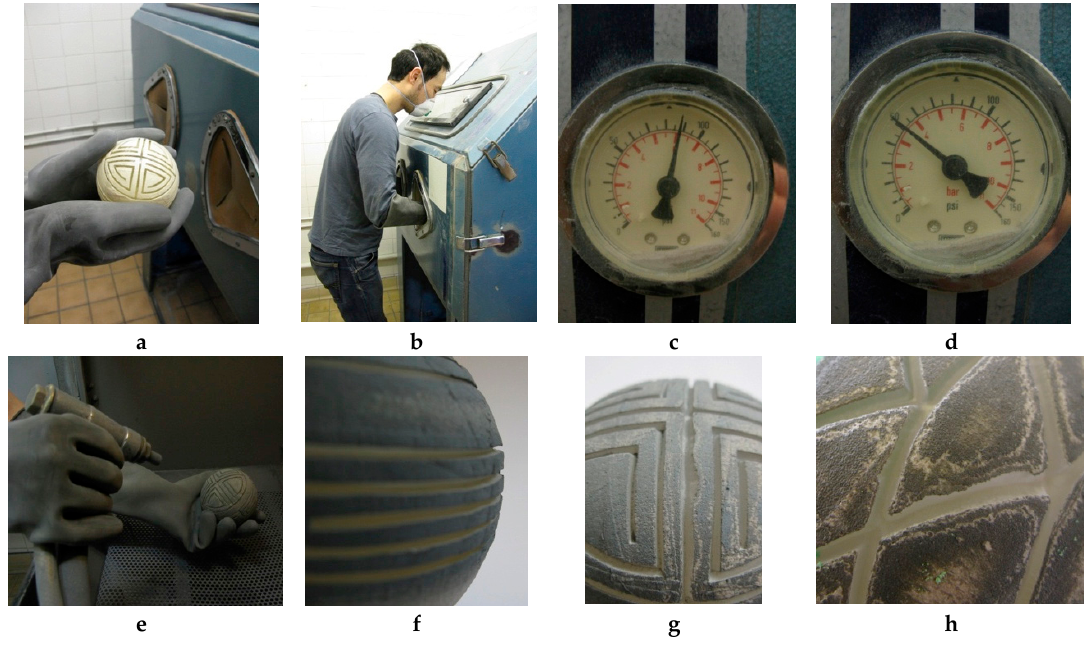
Figure 6. The sandblasting processes.